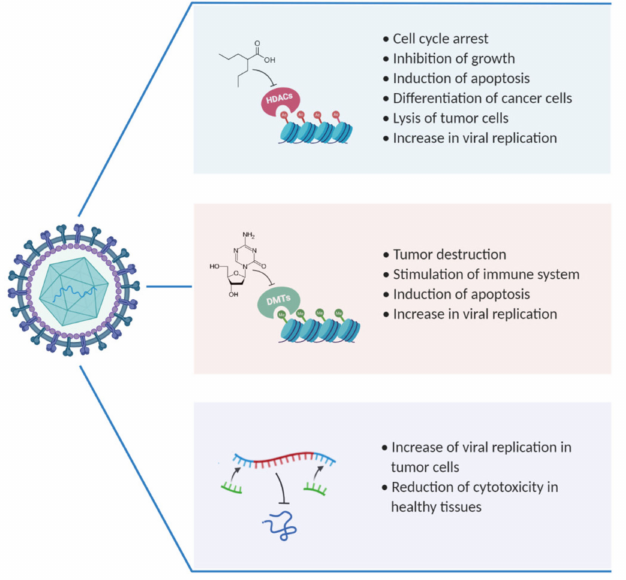
Figure 1. Summarizes the effects of combinatorial treatment by the use of OVs, epigenetic modulators and miRNA. Created with